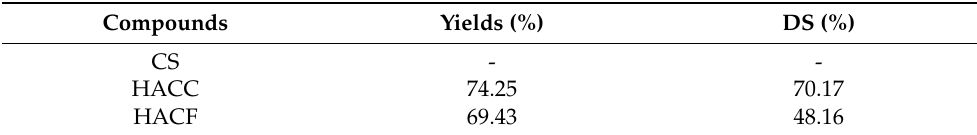
Table 1. Yields and DS of chitosan derivatives.